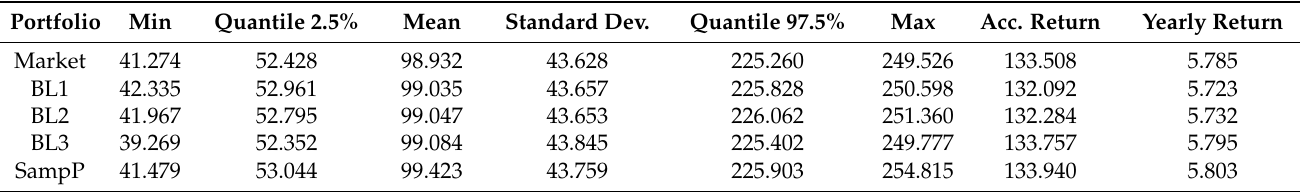
Table 1. Statistical summary of the simulated portfolios’ base 100 values. Table 2. Statistical summary of the simulated portfolio’s returns.